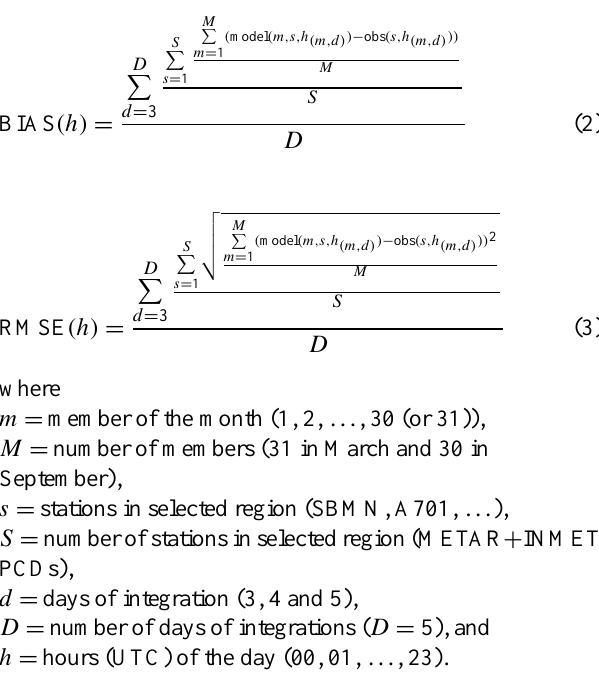
Fig. 3. Method for evaluation of the simulations. (a) Simulated data of each member is compared with observed data from similar time; (b) obtain RMSE (or BIAS) to 120h of model integrate for each station; (c) arithmetic mean of the errors at all stations in the desired domain is calculated; and (d) the first two days of integration are ignored and the mean of the last three days is calculated.